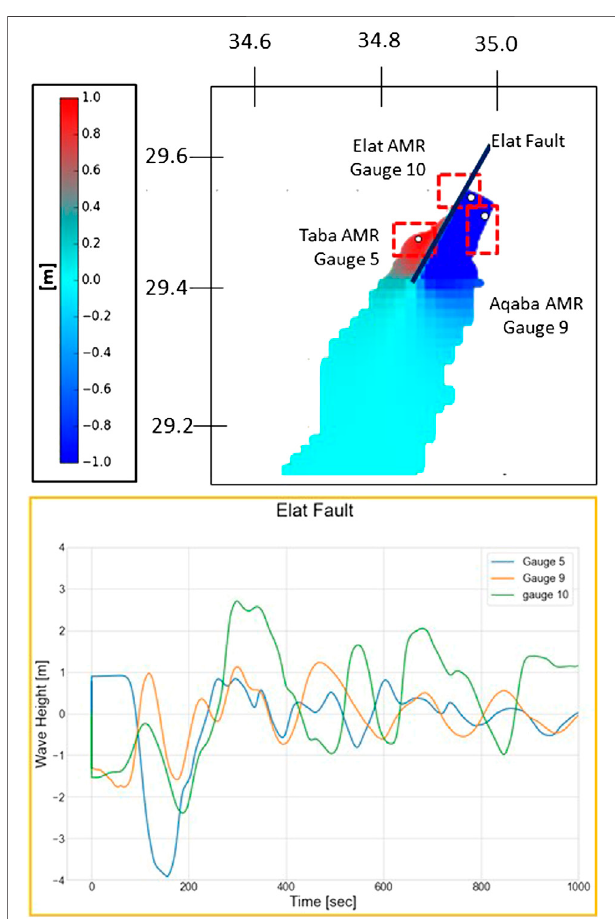
FIGURE 6 | Elat fault (EF, black line) tsunami scenario simulated by GeoClaw. See Realistic Elat Fault Tsunami Scenario for detailed explanation and Figure 1 for the location. The upper fi gure shows a snapshot of the water surface taken 1 s after the start of the simulated event, and the lower diagram presents waveforms of the fi rst 1,000 s as recorded by the arti fi cial tide gauges of Taba (gauge #5), Elat (10#) and Aqaba (#9). Note the coseismic deformation effect on the tide gauges at the start of the event (time (cid:2) 0): Taba (#5) goes up and Elat (#10) and Aqaba(9#) goesdown. AMRlocationsaremarked by red, dashed line squares.